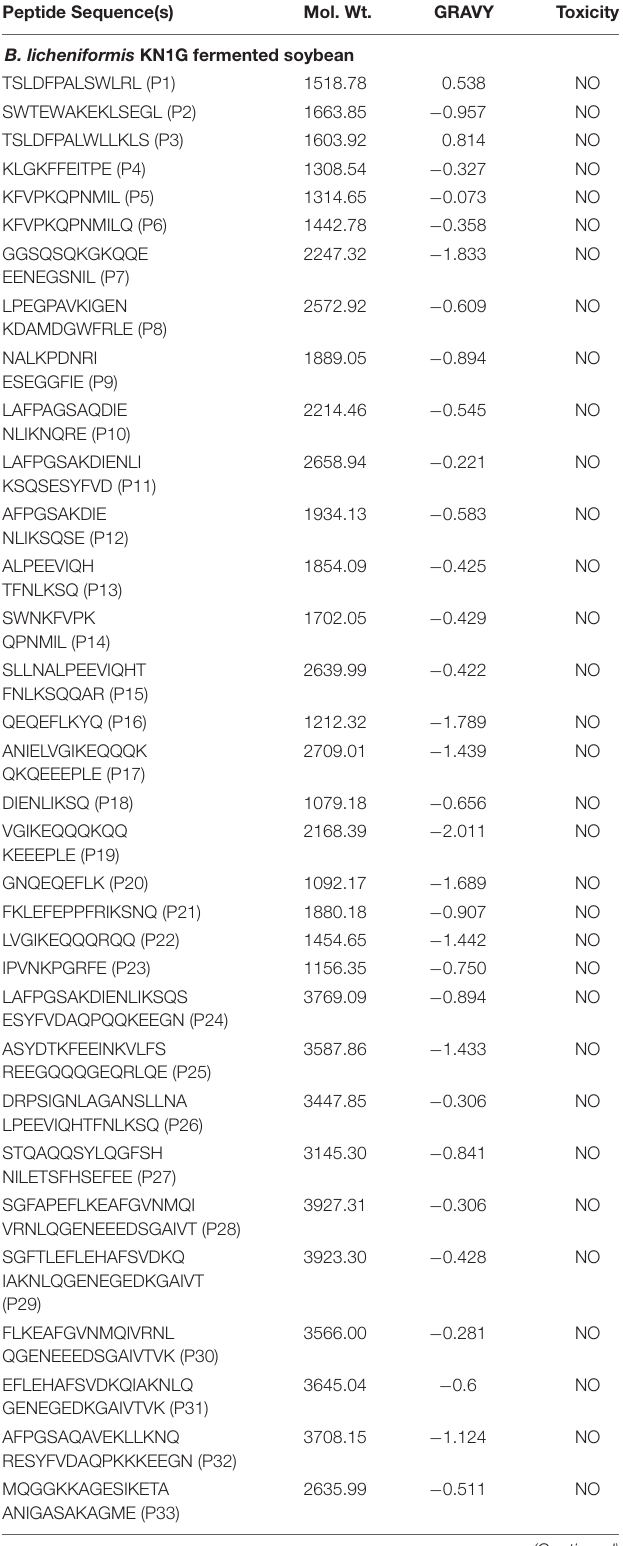
TABLE 1 | Peptide sequences, source hydrolysate and computed physicochemical features. Peptide Sequence(s) Mol.